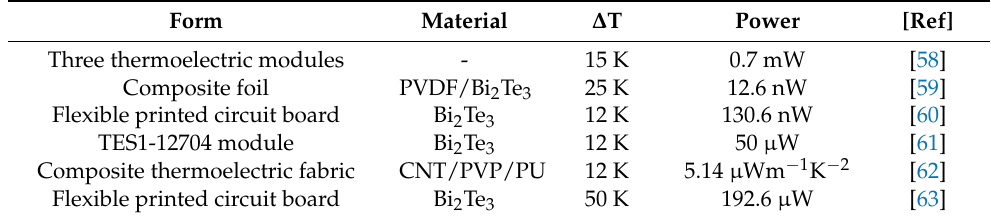
Table 7. Comparison of thermoelectric